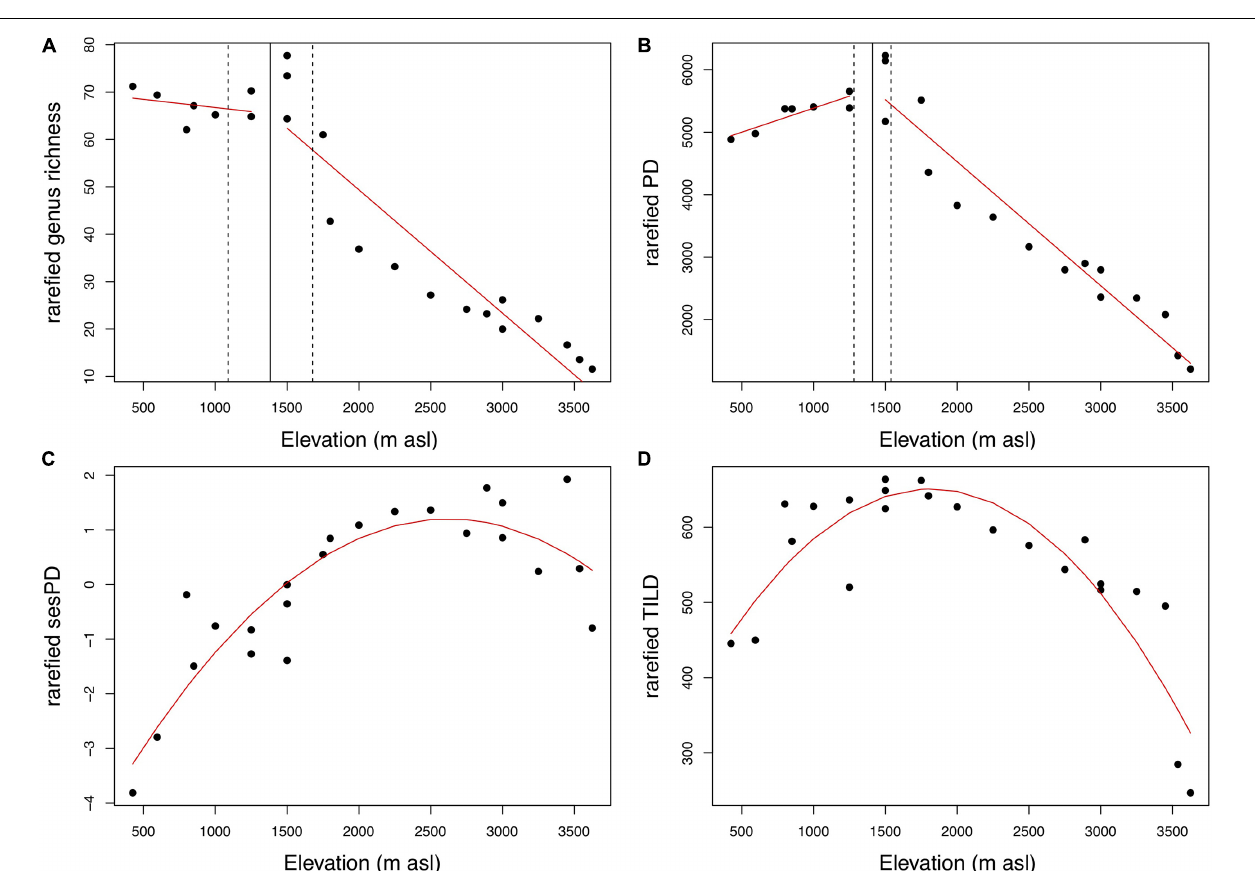
FIGURE 2 | The shape of the elevational richness gradient varies between metrics. (A) Genus richness and (B) phylogenetic diversity (PD) are best described by breakpoint regression models. (C) Standardized effect size phylogenetic diversity (sesPD) and (D) time integrated lineage diversity (TILD), are best described by quadratic regression models. Points are mean rarefied metric values for each plot. Red lines represent regression lines from the best fitting model for each metric. For figures a and b, the solid vertical line indicates the estimated breakpoint, with respective standard error represented by vertical dashed lines.